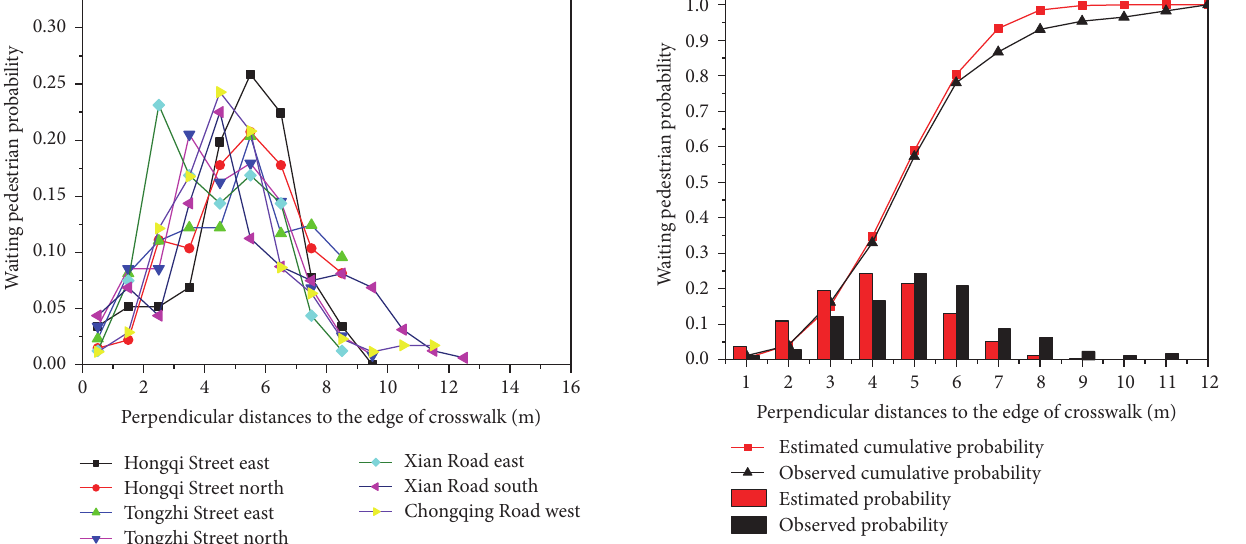
Figure 4: Pedestrian waiting position distributions.